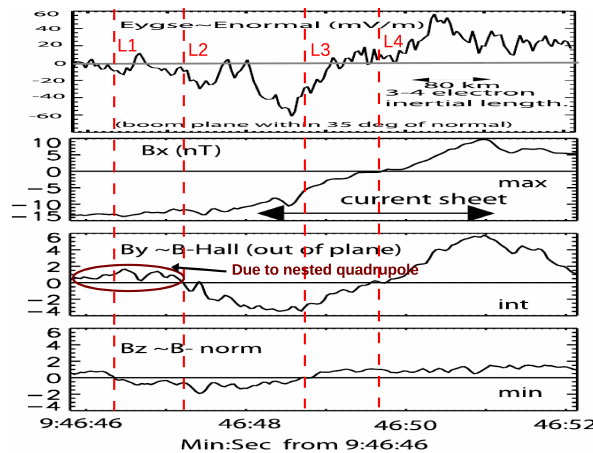
Figure 1. Magnetic field lines (black) plotted over color-coded B y at ω ce t = 45 (a) and =145 (b) . The primary ( P ) and secondary ( S 1 and S 2 ) sites are marked by crosses ( × S ). At ω ce t = 145, outward oblique propagation of whistlers from secondary sites forms a new quadrupole, marked with “+” and “–”. In (b) , the poles of primary, secondary and new quadrupoles are marked by Q’s (see text for def- inition) in the left half. The red dashed loop encloses a negative pole of the extended quadrupole. The blue line in the top right quadrant is at an angle of 19.5 ◦ with the background magnetic field along + x and approximates the wave normal. The profile of B y along the wave normal is shown in (c) . The black line with an arrow in (b) shows a possible trajectory of the Cluster spacecraft.